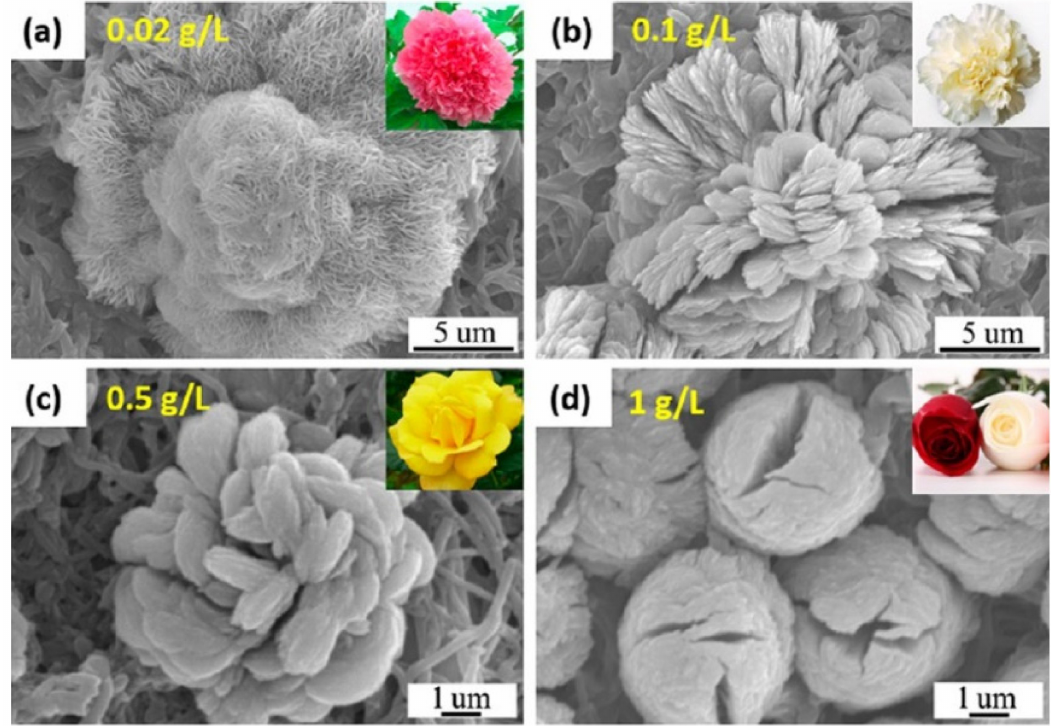
Figure 12. SEM of Cu-BSA hNFs with different protein concentrations, with an incubation time of 6 h. Reprinted from [42] with permission from the American Chemical Society. Copyright © 2021 American Chemical